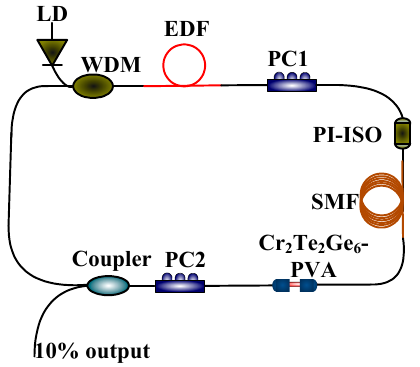
Figure 6. Experimental construction of the Cr 2 Ge 2 Te 6 -PVA-based Er-doped pulsed fiber laser.